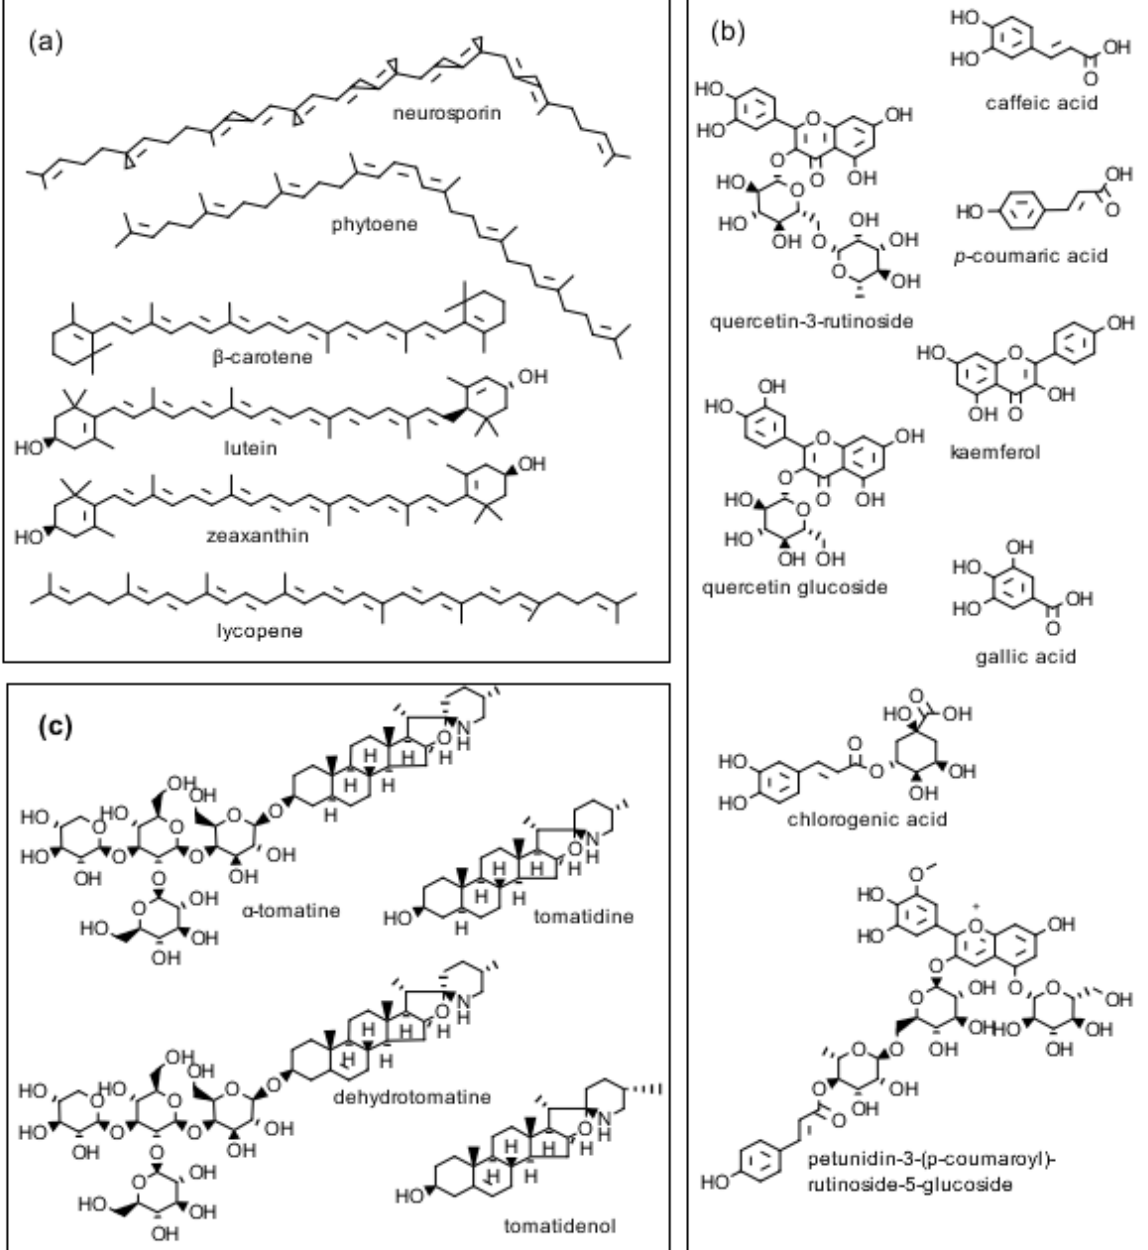
Figure 1. Structures of three classes of biologically active tomato compounds: ( a ) pigments; ( b ) phenolics and flavonoids; and ( c ) the glycoalkaloid α-tomatine; the aglycone tomatidine; the glycoalkaloid dehydrotomatine; and the aglycone tomatidenol. (Isomers of α-tomatine and dehydrotomatine are not shown.).